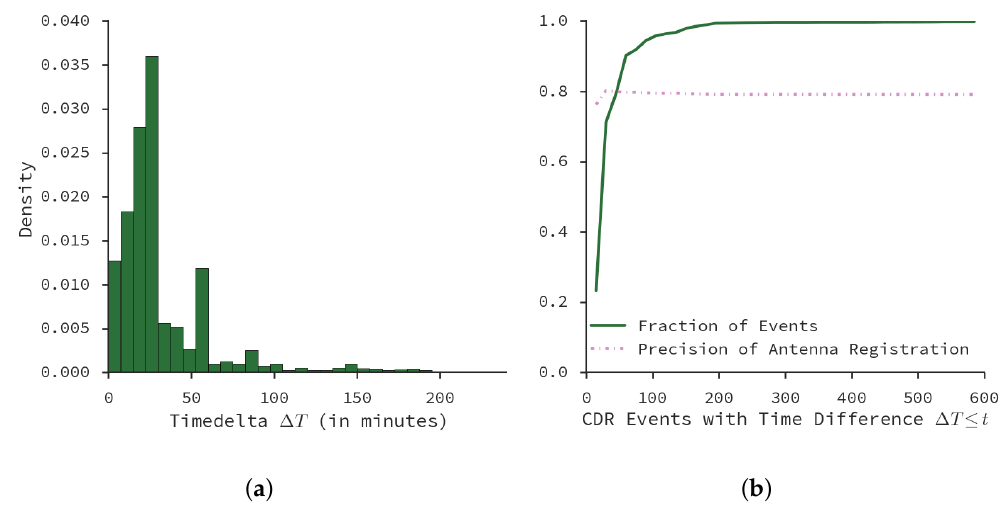
Figure A1. Differences in timing and antenna id between a CDR dataset and a network traffic monitoring dataset: ( a ) histogram of timestamp differences, in minutes (capped at 240 min for clarity); ( b ) precision and cumulative distribution of devices considering the timestamp